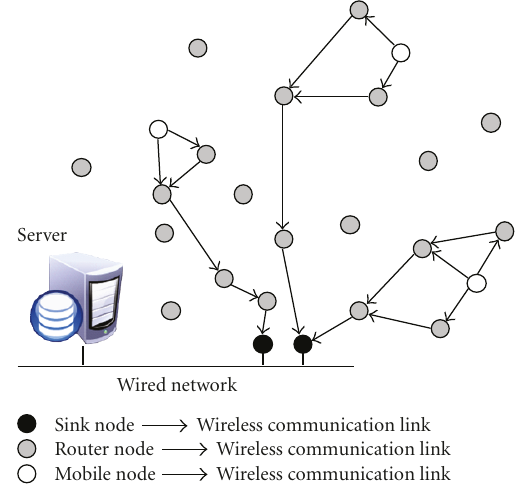
Figure 2: Hospital security WSN topology. The router nodes forward data via multiple hops to one or multiple sinks. Mobile nodes broadcast their data to the router